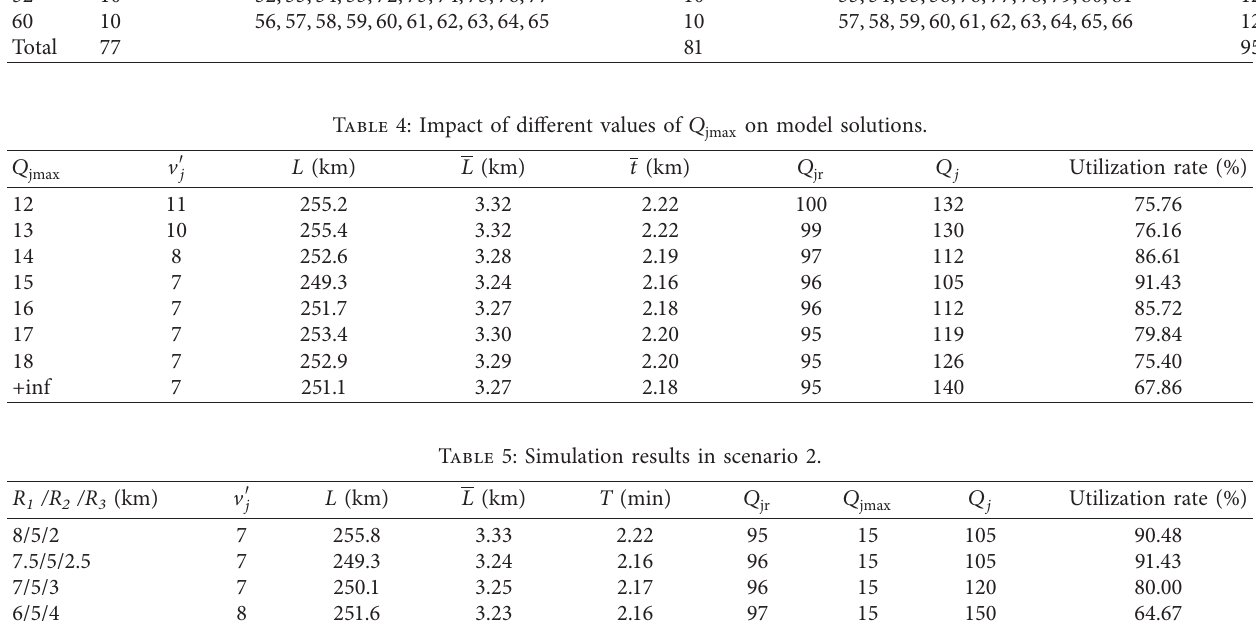
Table 4: Impact of different values of Q